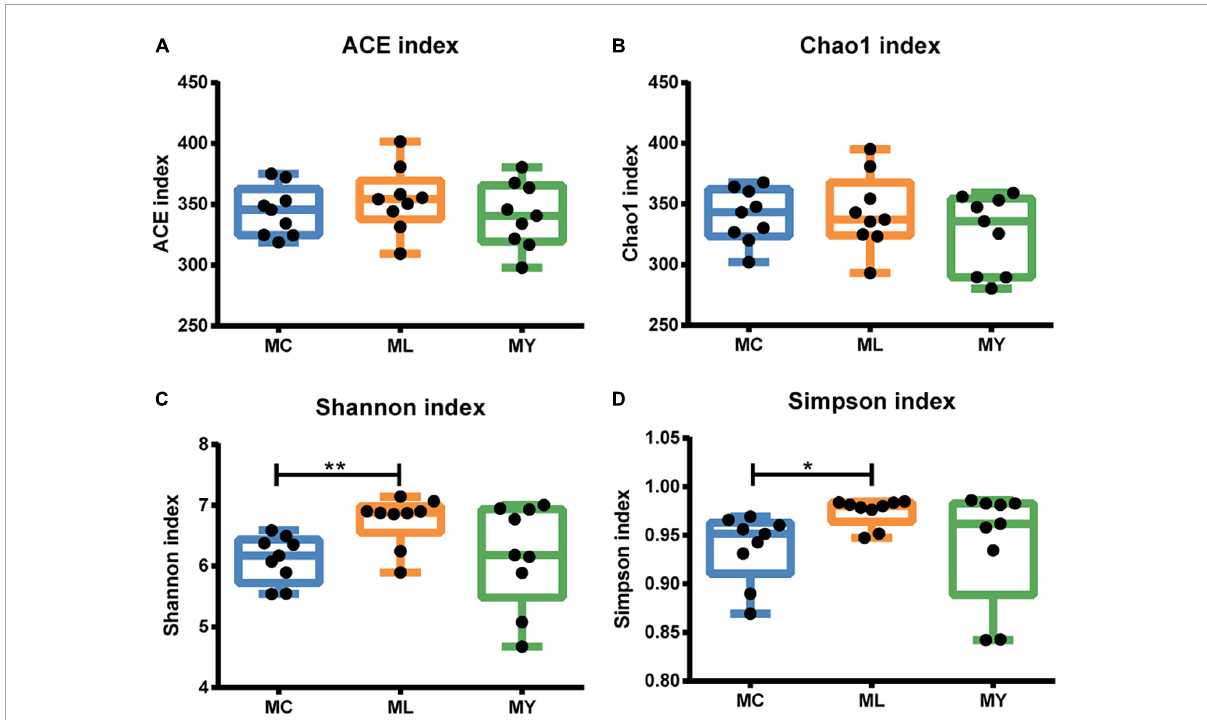
FIGURE2 Beta diversity analysis of ruminal bacteria. (A) Principal component analysis (PCA), and (B) principal coordinates analysis (PCoA). MC, control group ( n = 9); ML, active dry yeast group ( n = 9); MY, yeast culture group ( n = 9).